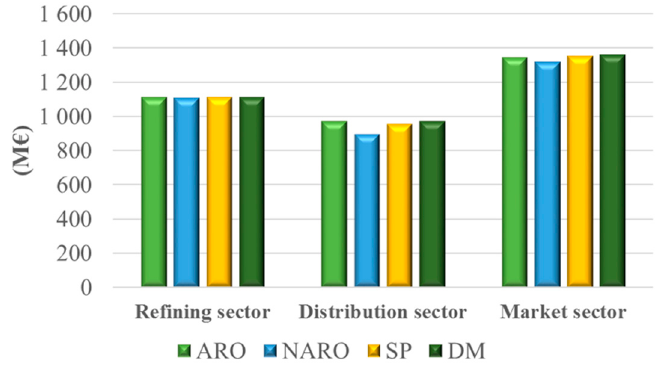
Figure 3. Comparison of profitability contributions among the optimization models.